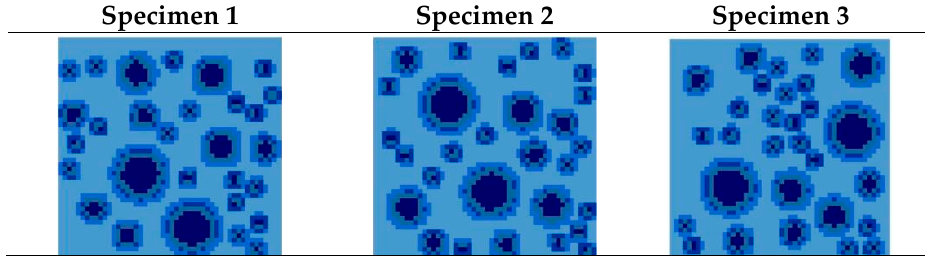
Table 2. Numerical simulation results